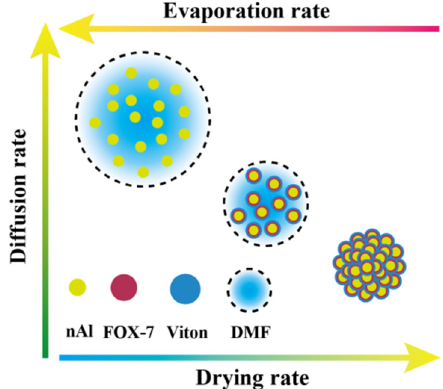
Figure 5. Schematic diagram showing the development of a droplet consisting of the co-solution of FOX-7 and Viton dispersed nAl during the spray-drying process. FOX-7 and Viton dispersed nAl during the spray-drying